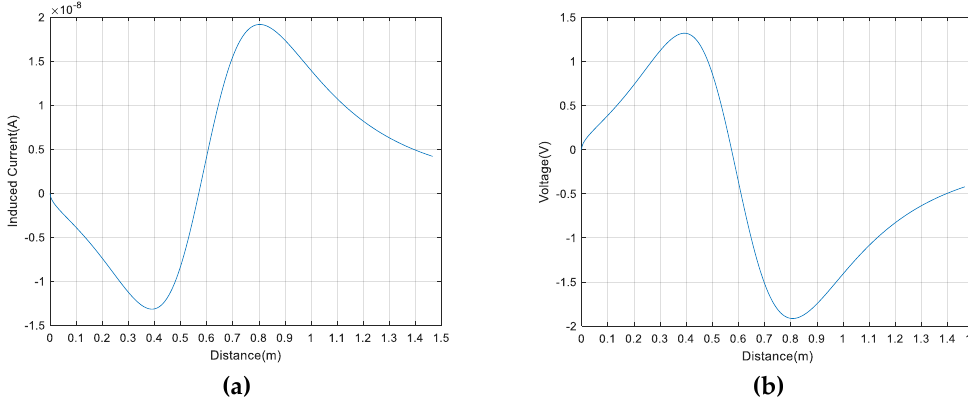
Figure 21. ( a ) Theoretical induced current, and ( b ) theoretical output after the charge amplifier.